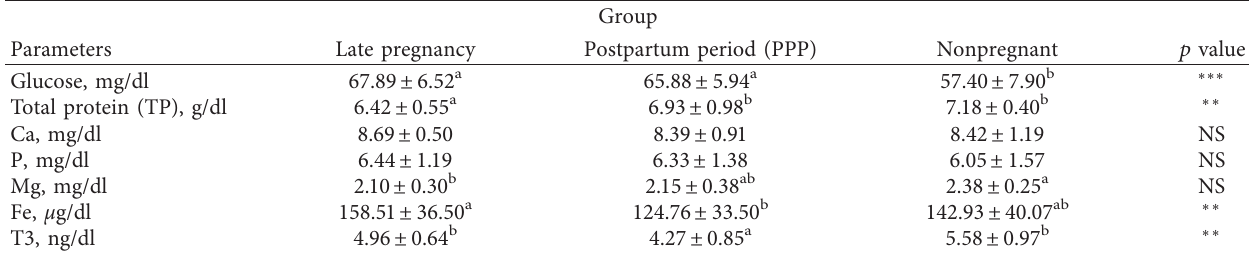
Table 2: Blood glucose, total protein (TP), calcium (Ca), phosphorus P, magnesium (Mg), iron (Fe), and triiodothyronine (T3) during late pregnancy and postpartum periods and in nonpregnant crossbred dairy cows. Results are expressed as mean ±